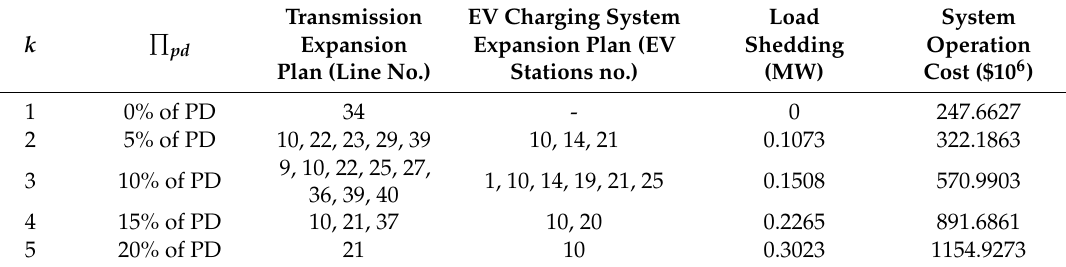
Table 3. IEEE 30-bus power system: Robust coordinated